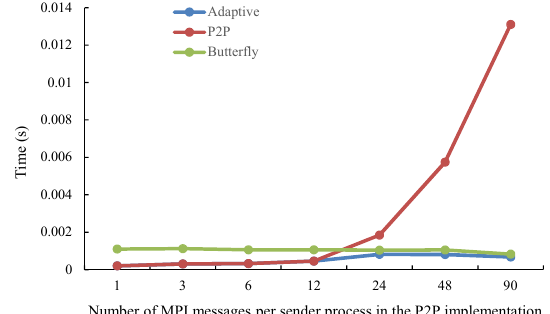
Figure 15. Average execution time ( y axis) of one data transfer be- tween two toy models with the same rectangular grid (of 192 × 480 grid points) when varying the number of MPI messages per sender process in the P2P implementation ( x axis). Each toy model is run with 1024 processes. There are 10 2-D coupling fields transferred from the source toy model to the target toy